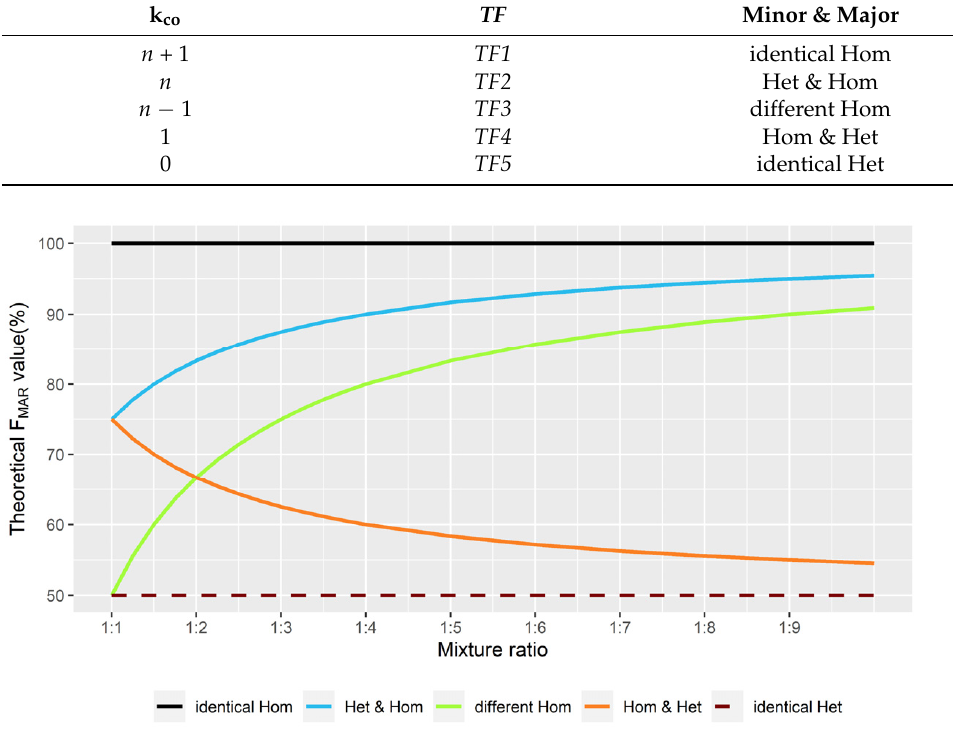
Figure 1. Illustration of the mixture ratio ( x -axis) against the theoretical F MAR values ( y -axis). The five lines in the graph are interpreted as follows. First, the black solid line at the top indicates TF1 , which always equals 100%. Second, the blue line indicates TF2 , which becomes higher and is infinitely close to 100%, as the proportion of the major contributor increases. For example, TF2 equals 95% and 97.5% at the ratios of 1:9 and 1:19, respectively. Third, the green line indicates TF3 , which becomes higher and is infinitely close to TF2 . TF3 equals 90% and 95% at the ratios of 1:9 and 1:19, respectively. Fourth, the red solid line indicates TF4 which becomes lower and is infinitely close to 50%. TF4 equals TF2 at the ratio of 1:1, and it equals TF3 at the ratio of 1:2. Fifth, the brown dashed line at the bottom indicates TF5 , which always equals